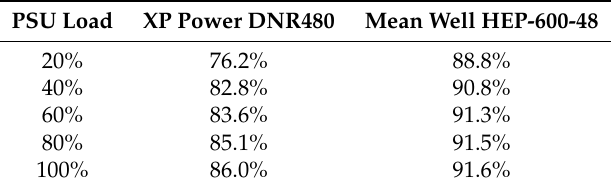
Figure 6. Efficiency measurements in function of output power for two 48 V DC power supplies using a resistive load bank. Table 3. Total system efficiency of a DC-based LED lighting system using Mean Well LDD-1000H LED drivers. The efficiency depends on the choice of power supply unit (PSU) and its load compared to its rated